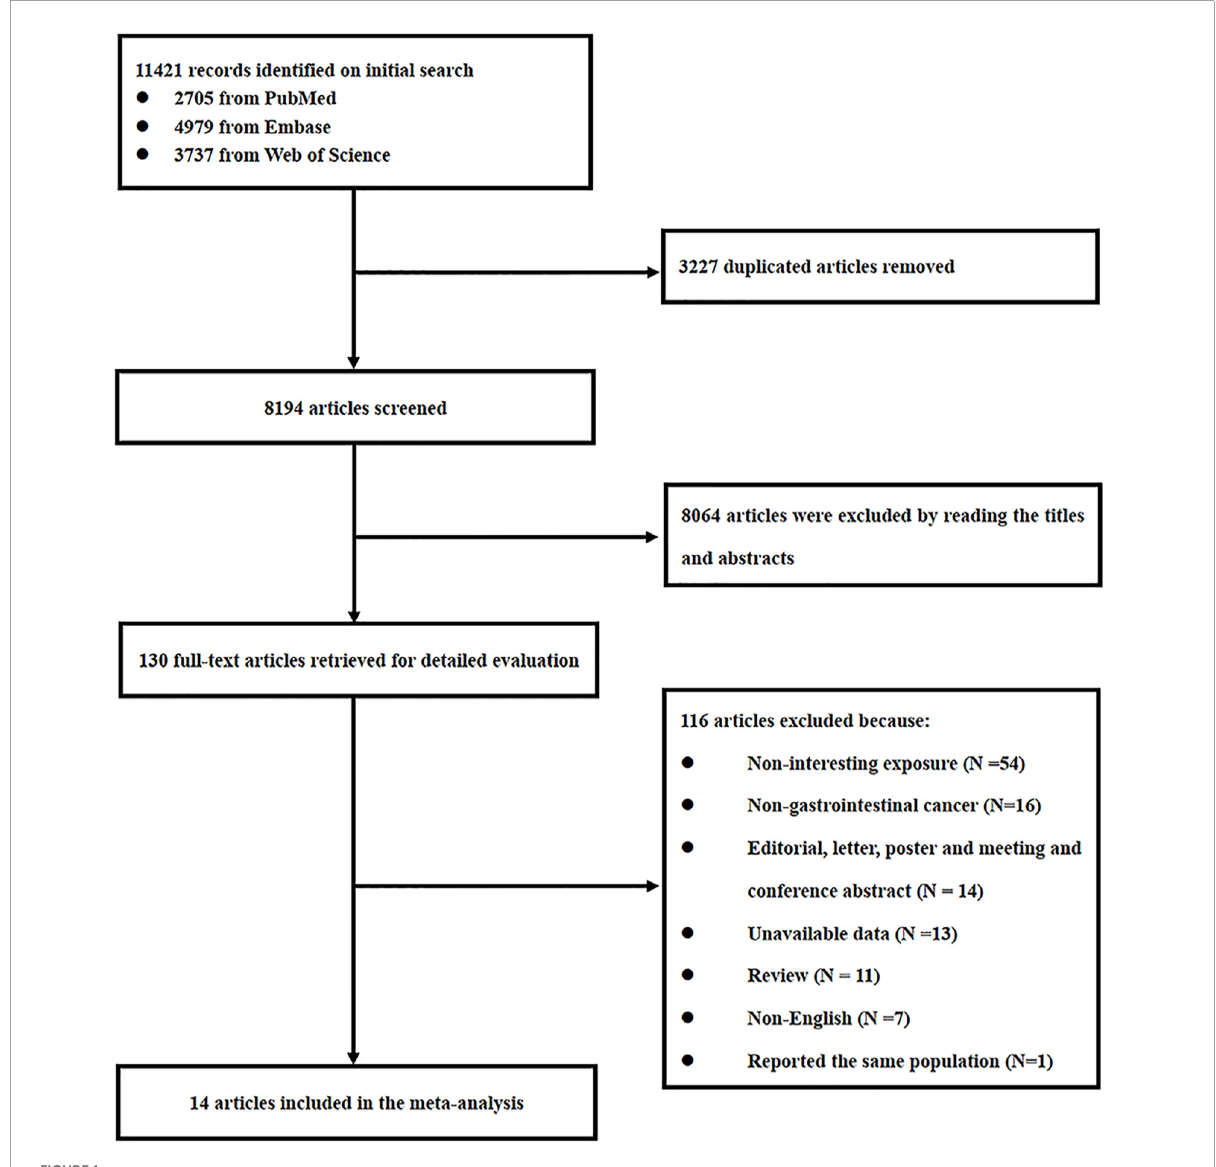
FIGURE1 Flowchart of the study selection